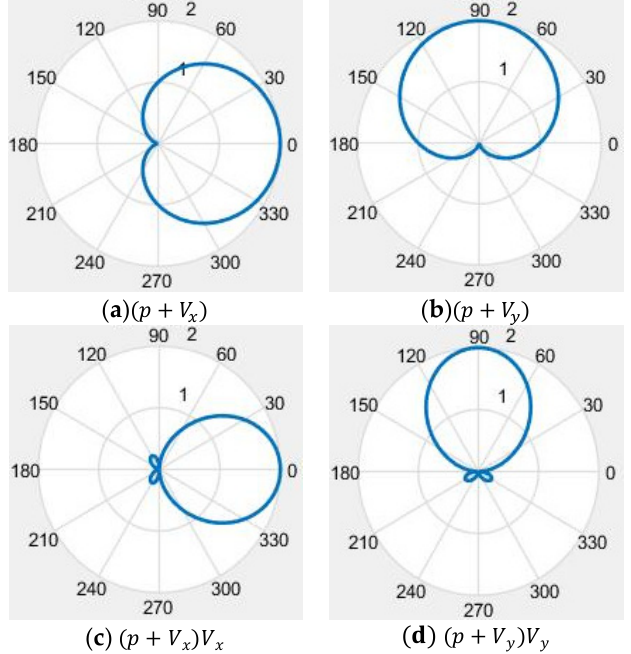
Figure 3. Directivity of the composite hydrophone. ( a , b ) Sound pressure and vibration velocity are combined by the mode of p + V i ( i = x , y ); ( c , d ) sound pressure and vibration velocity are combined by the mode of ( p + V i ) V i ( i = x , y ).